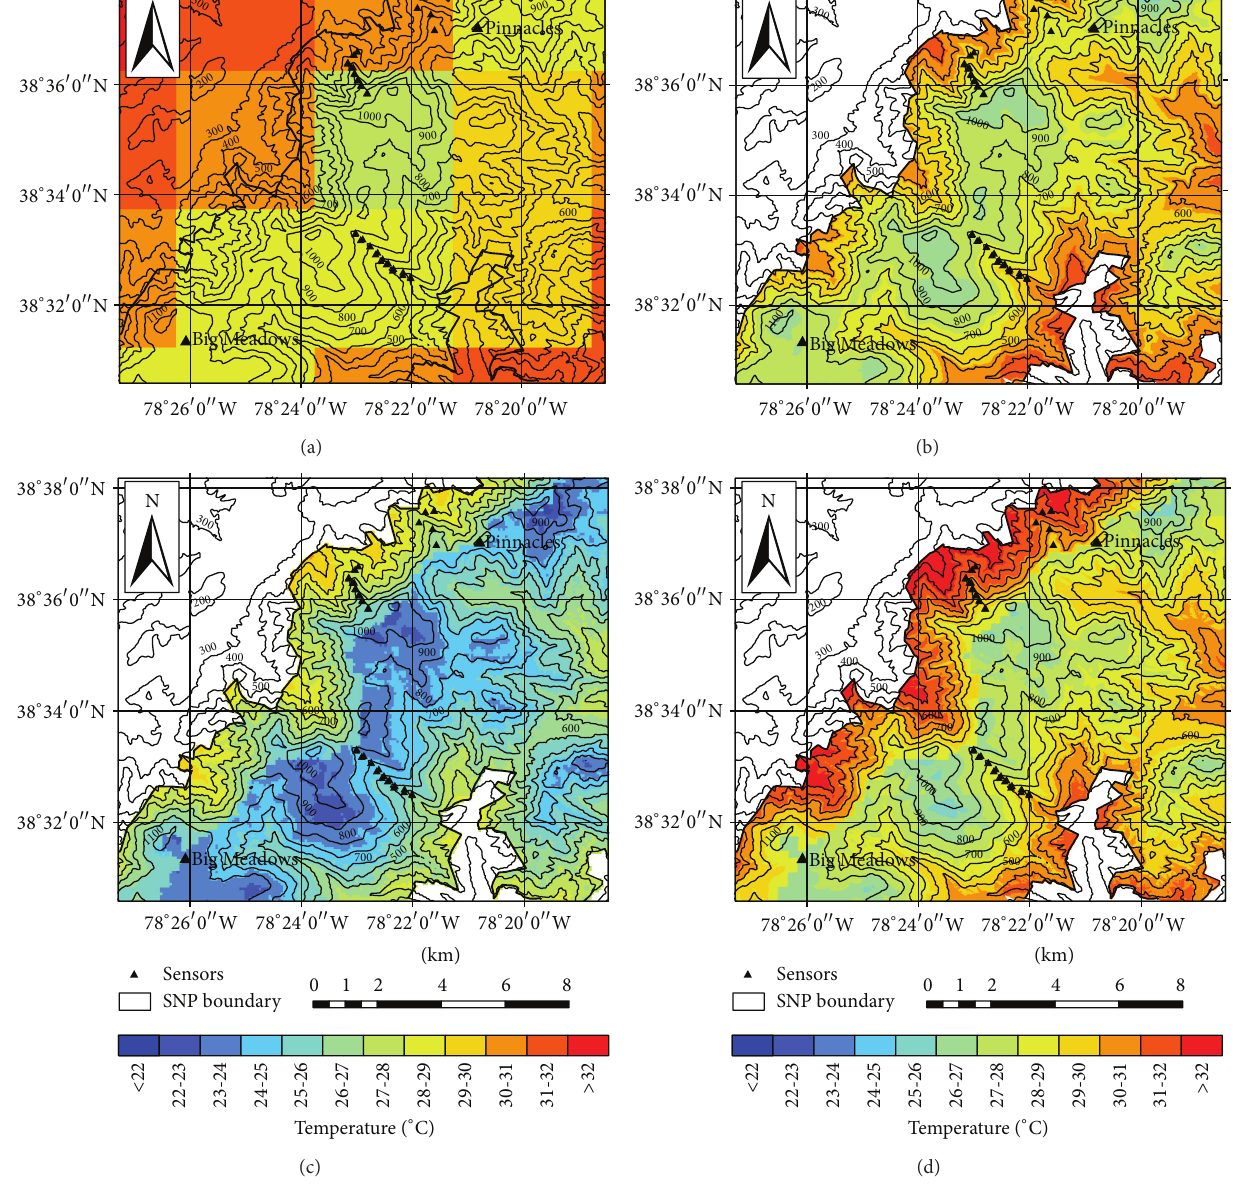
Figure 4: Maps of mean 𝑇 max for July 2012 resulting from the different steps in our downscaling method. Panel (a) shows 4km PRISM output; panel (b) shows PRISM downscaled to 15m in SNP using the 30-year PRISM lapse rates and without any corrections applied; panel (c) shows PRISM downscaled to 15m in SNP with our corrections from Table 1 applied to each 15m grid box; panel (d) shows estimated mean 𝑇 max in SNP assuming a temperature increase of 3.3 ∘ C (average projected temperature increase from NARCCAP RCMs for SNP) applied to July, 2012 mean 𝑇 max . Thin black lines denote elevation contours at 100m spacing, with contour lines labeled; solid black line indicates the SNP boundary; black triangles mark temperature sensors; and the two ridgetop climate monitoring stations, Big Meadows and Pinnacles, are labeled. Note that the downscaling method is only applied to a 15 m DEM inside the SNP boundary (panels